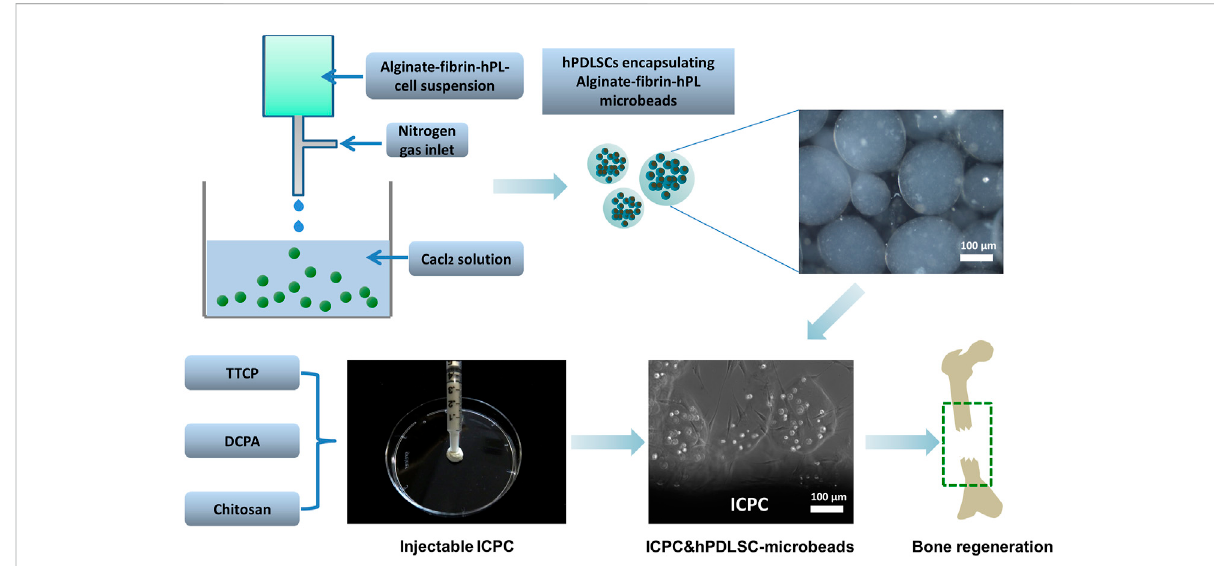
FIGURE 8 Schematic illustration showing the encapsulation of hPDLSCs in alginate microbeads incorporated with hPL and delivery with ICPC for bone regeneration.